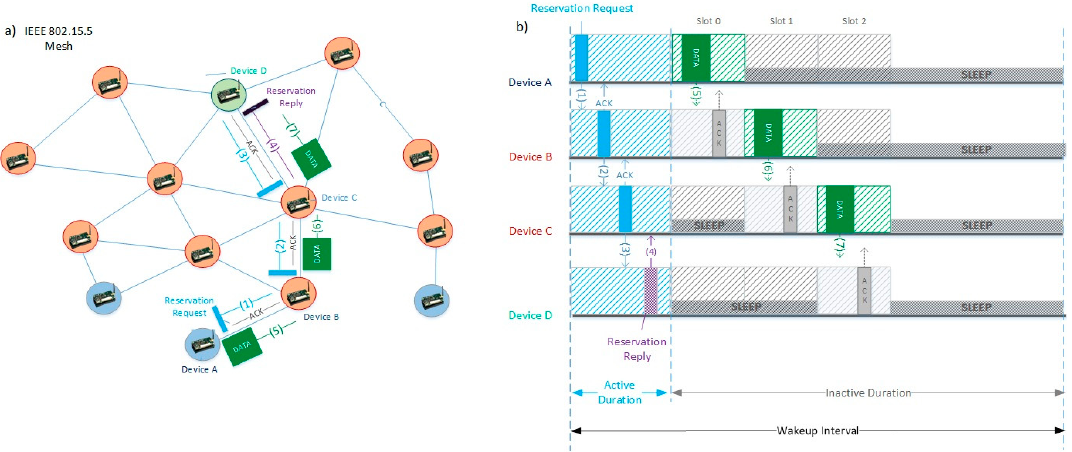
Figure 5. Data transmission in SES. ( a ) Topological view; ( b ) Time structure view.